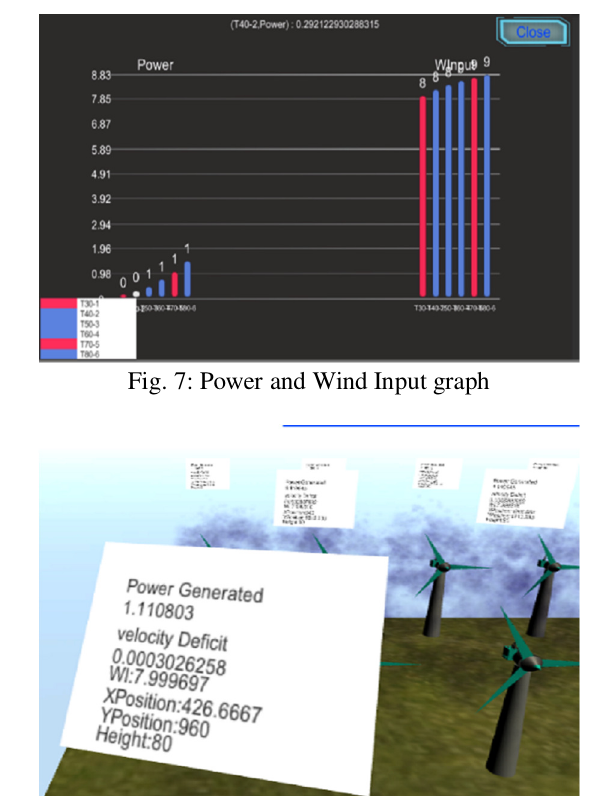
Fig. 8: Turbine canvas placed on each